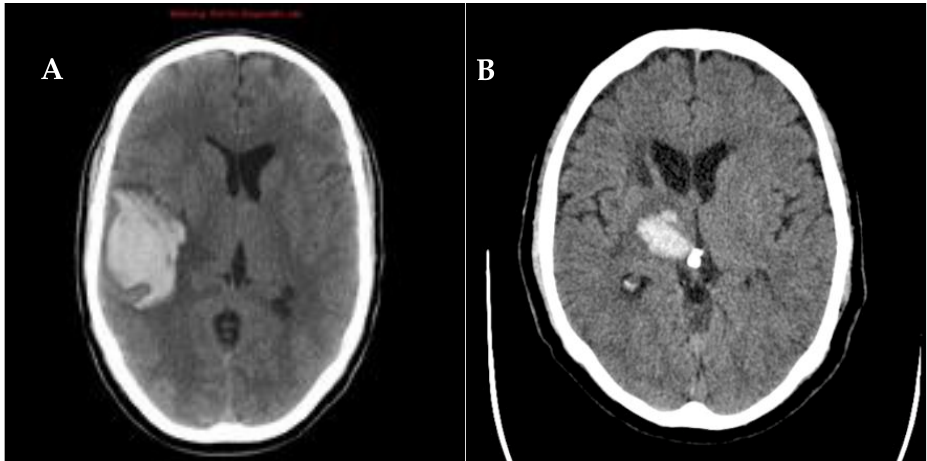
Figure 1. Lobar cerebral hemorrhage ( A ) and deep subcortical intracerebral hemorrhage of thalamic topography ( B ). Axial non-contrast brain CT scan.